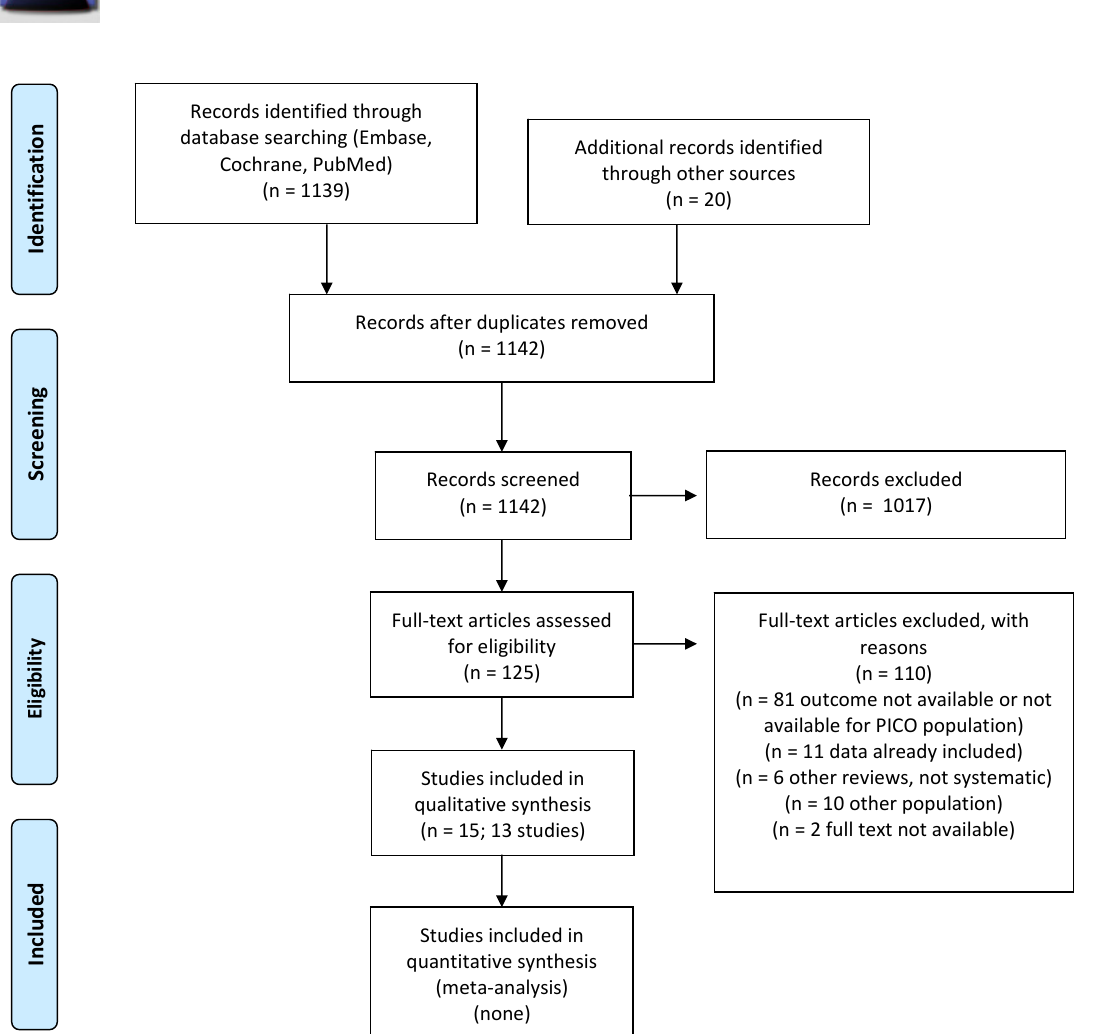
Figure 1. PICO A: PRISMA flow-chart for incidence of secondary